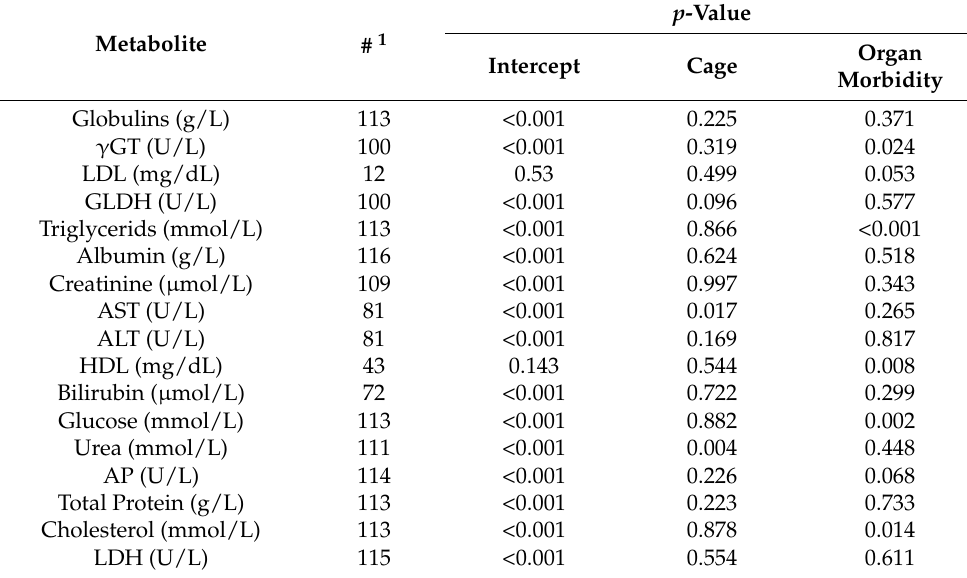
Table 1. Results of the linear mixed-effects